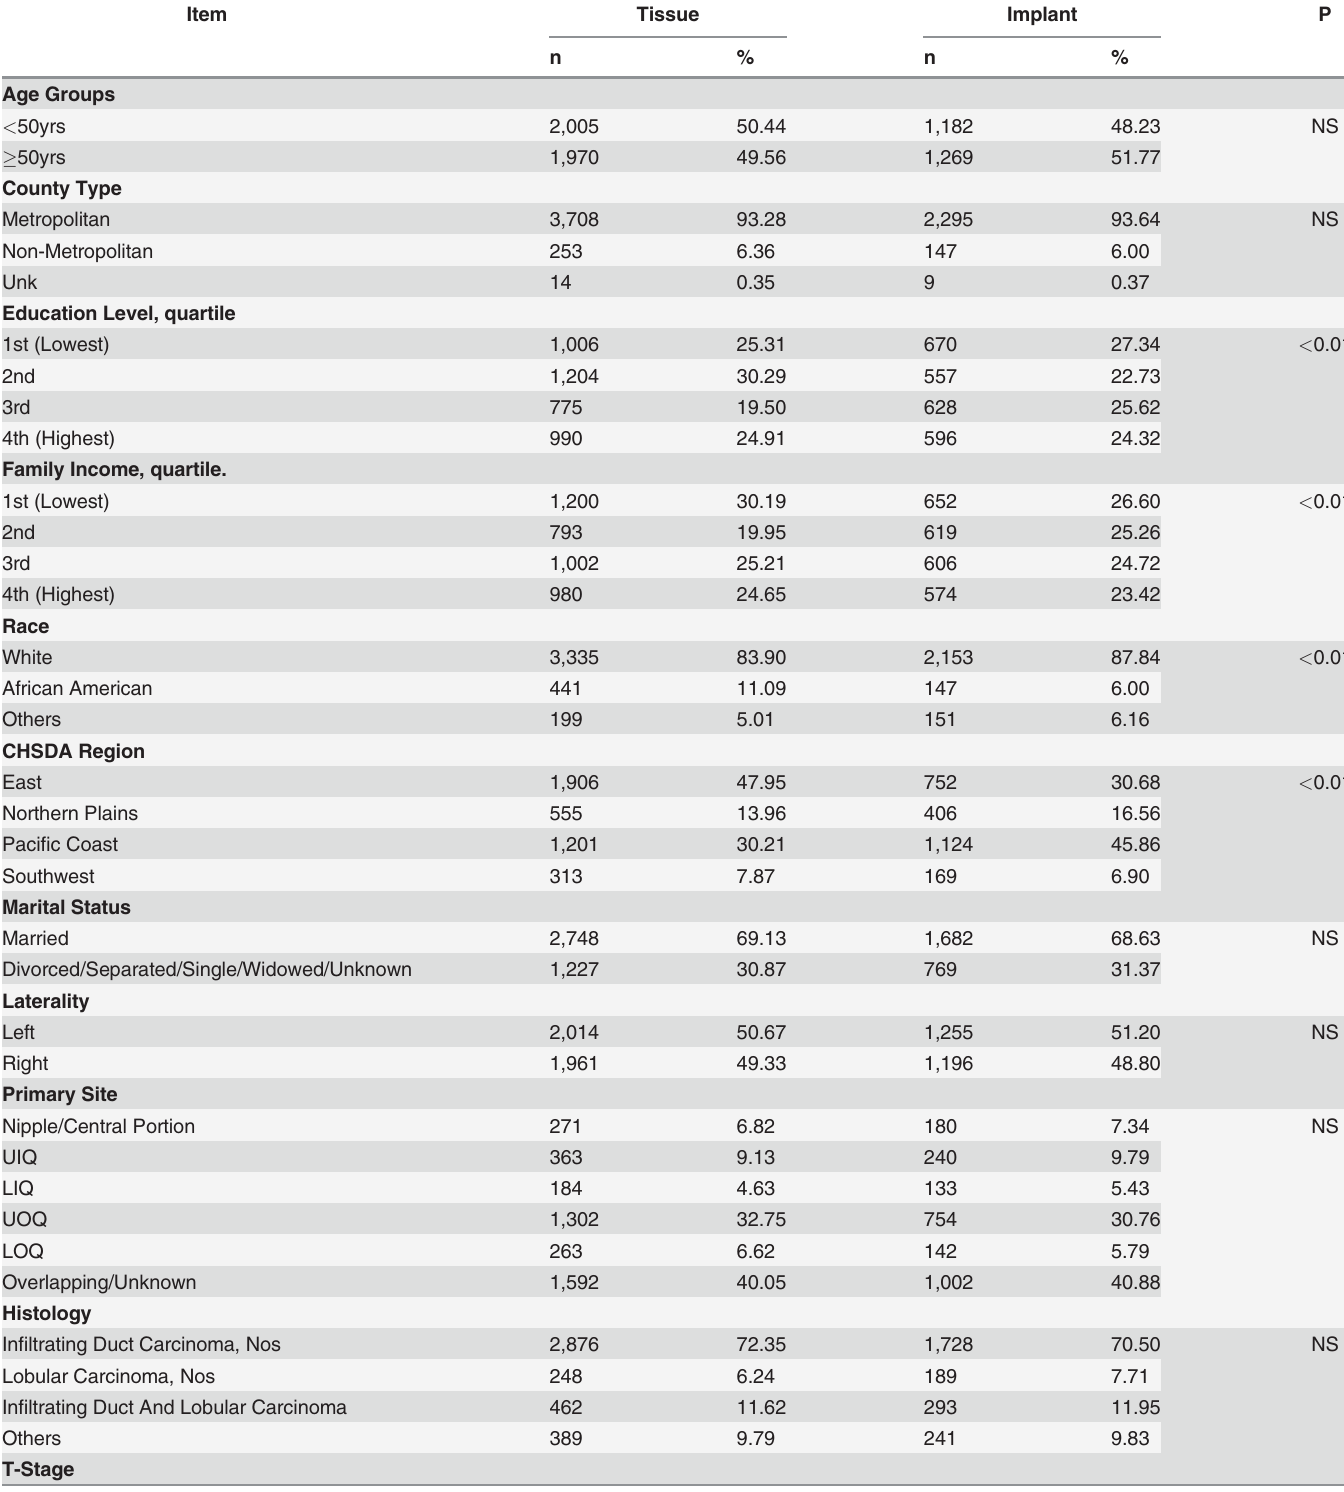
Table 1. Characteristics of patients included in this study.